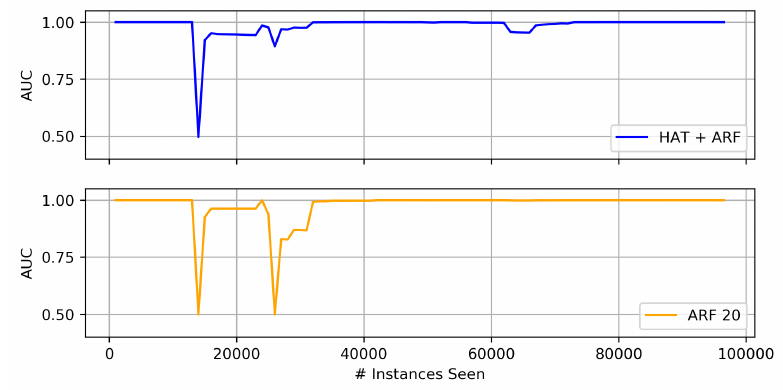
Figure 9. Performance comparison of heterogeneous (HAT + ARF) and homogeneous (ARF) ensembles on